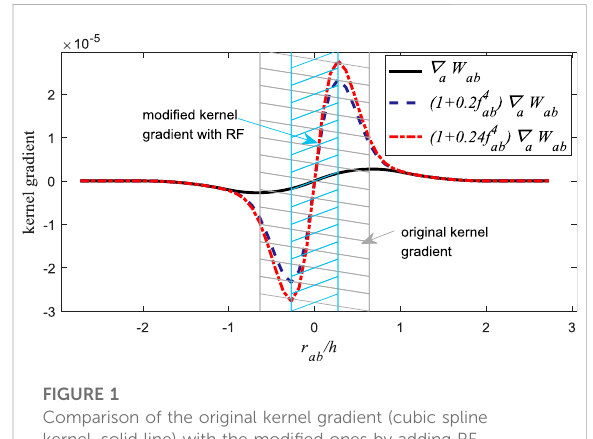
FIGURE 1 Comparison of the original kernel gradient (cubic spline kernel, solid line) with the modi fi ed ones by adding